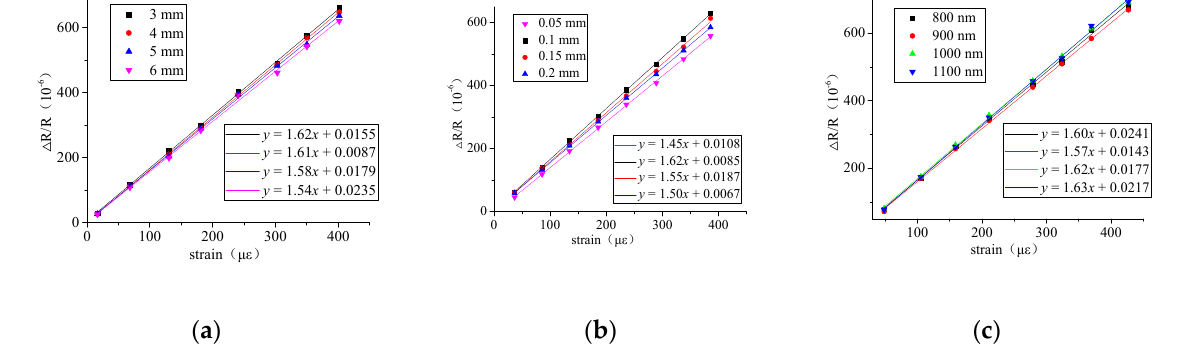
Figure 8. Tensile test results of structure parameters of resistor gratings prepared by etching method. ( a ) Effect of resistance grid length on resistance strain coefficient; ( b ) Effect of resistance grid width on resistance strain coefficient; ( c ) Effect of resistance grid thickness on resistance strain coefficient.